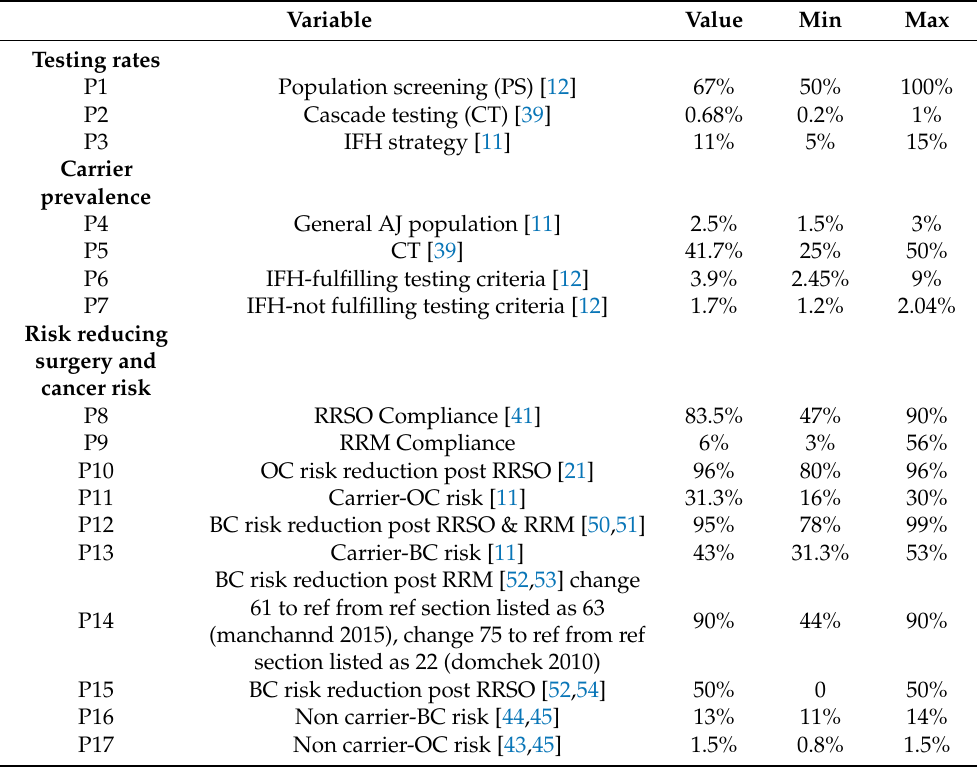
Table 1. Probabilities in decision tree 1